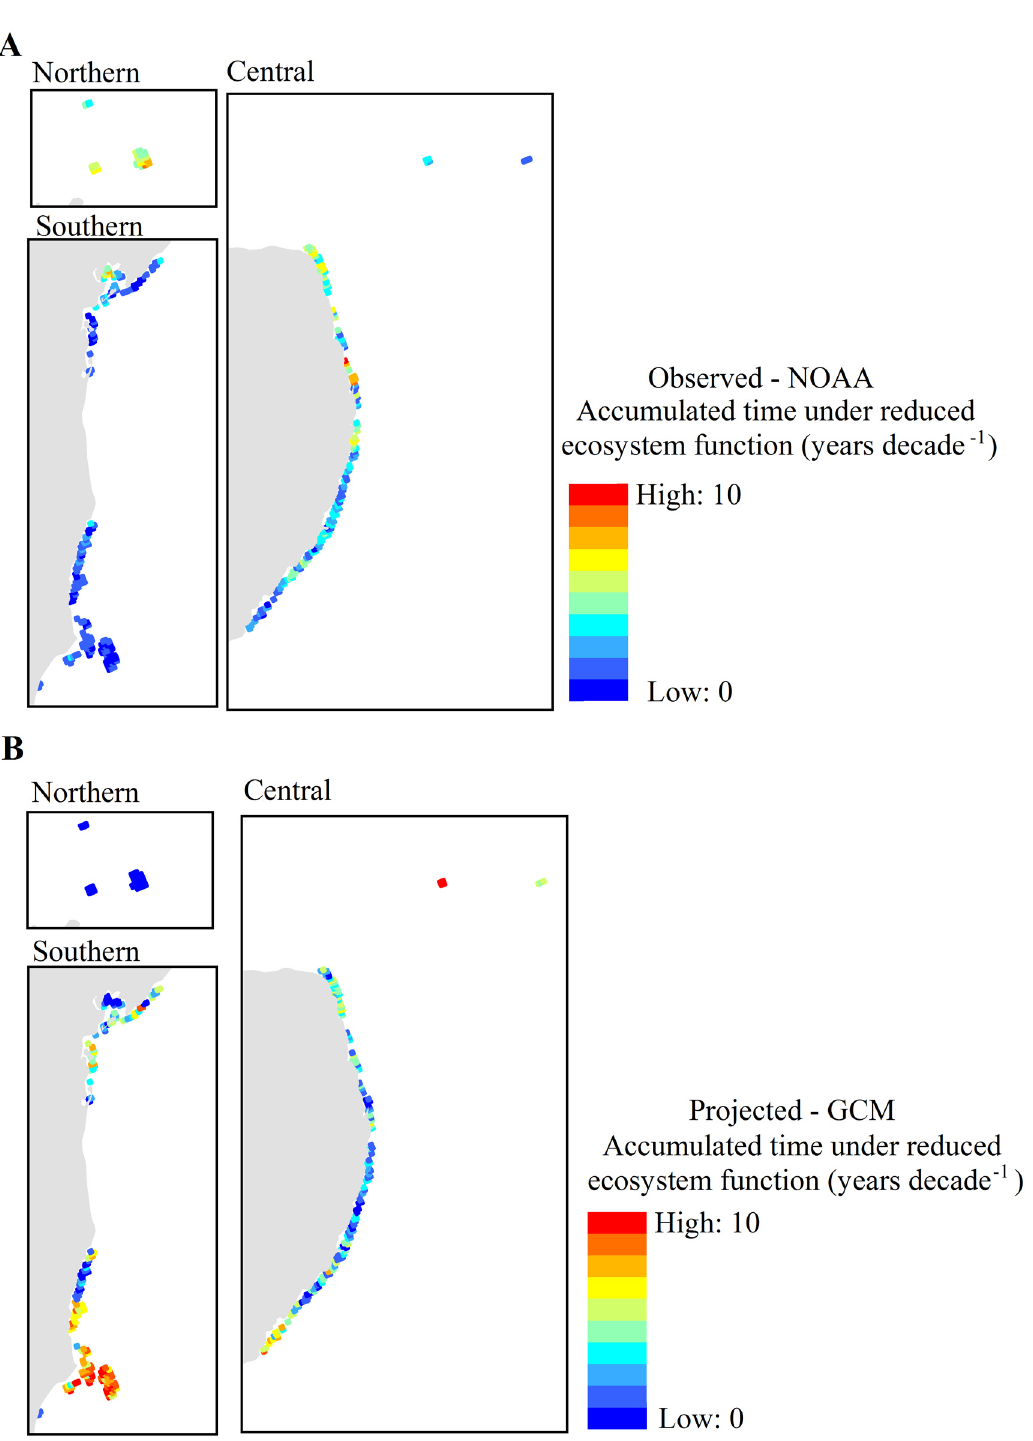
Fig 7. The acute thermal stress metric. Accumulated time for which the ecosystem is under reduced ecosystem function from acute stress events for all reef cells according to observed (A) and projected (B) time series. Times are derived from the logistic function used to relate intensity of acute stress events to recovery time (Fig 3) and summed through each time-series and presented as years per decade. Panels for reefs in the northern, central, and southern sectors of the study area correspond to insets in Fig 2A.